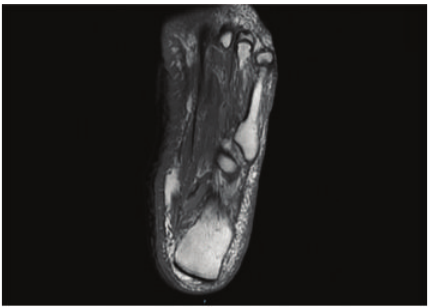
Figure 5: MRI of the left foot with contrast showing diffuse soft tissue T1 hypointense signal within both medial and lateral subcutaneous tissues, which is more prominent in the fat anterior to the Achilles tendon.